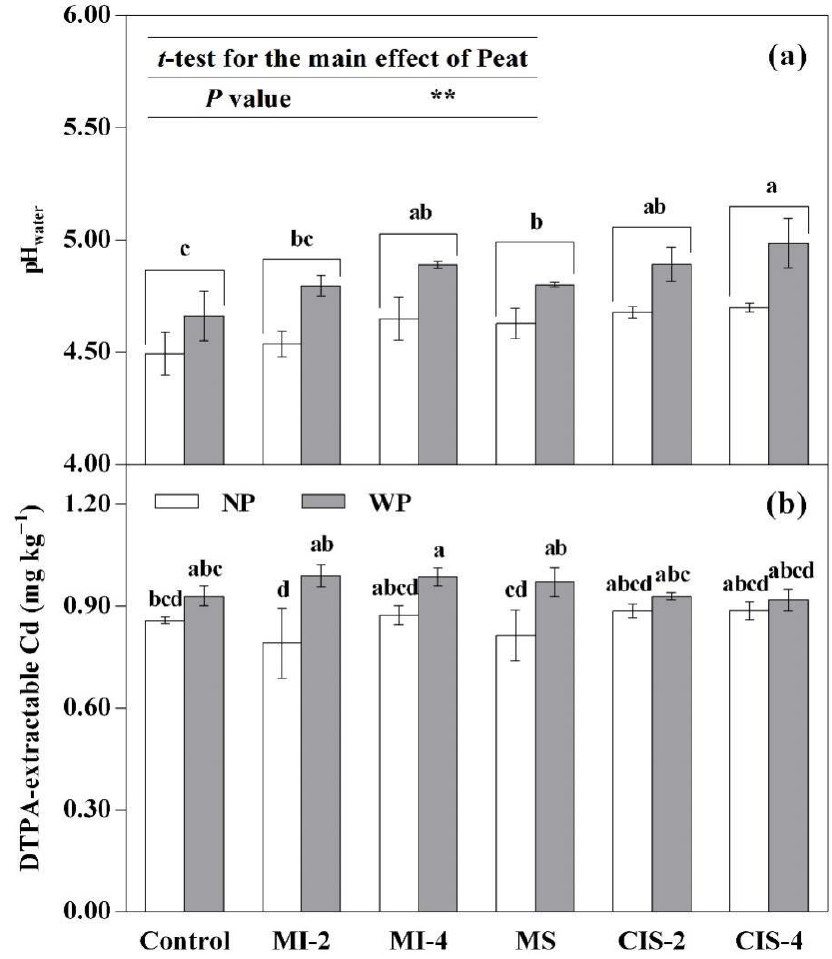
Figure 1. Effects of planting pattern and peat application on pH water ( a ) and DTPA-extractable Cd ( b ) in soil. For explanation of treatment notations, see Table 2; data are expressed as means ± SD ( n = 3); different lowercase letters (e.g., a, b, c, etc.) indicate significant ( p < 0.05) differences among the planting patterns (the interaction between planting pattern and peat application was non-significant) or among the treatments based on the Tukey test; the asterisk indicates a highly significant (** p < 0.01) difference between the NP and WP treatment